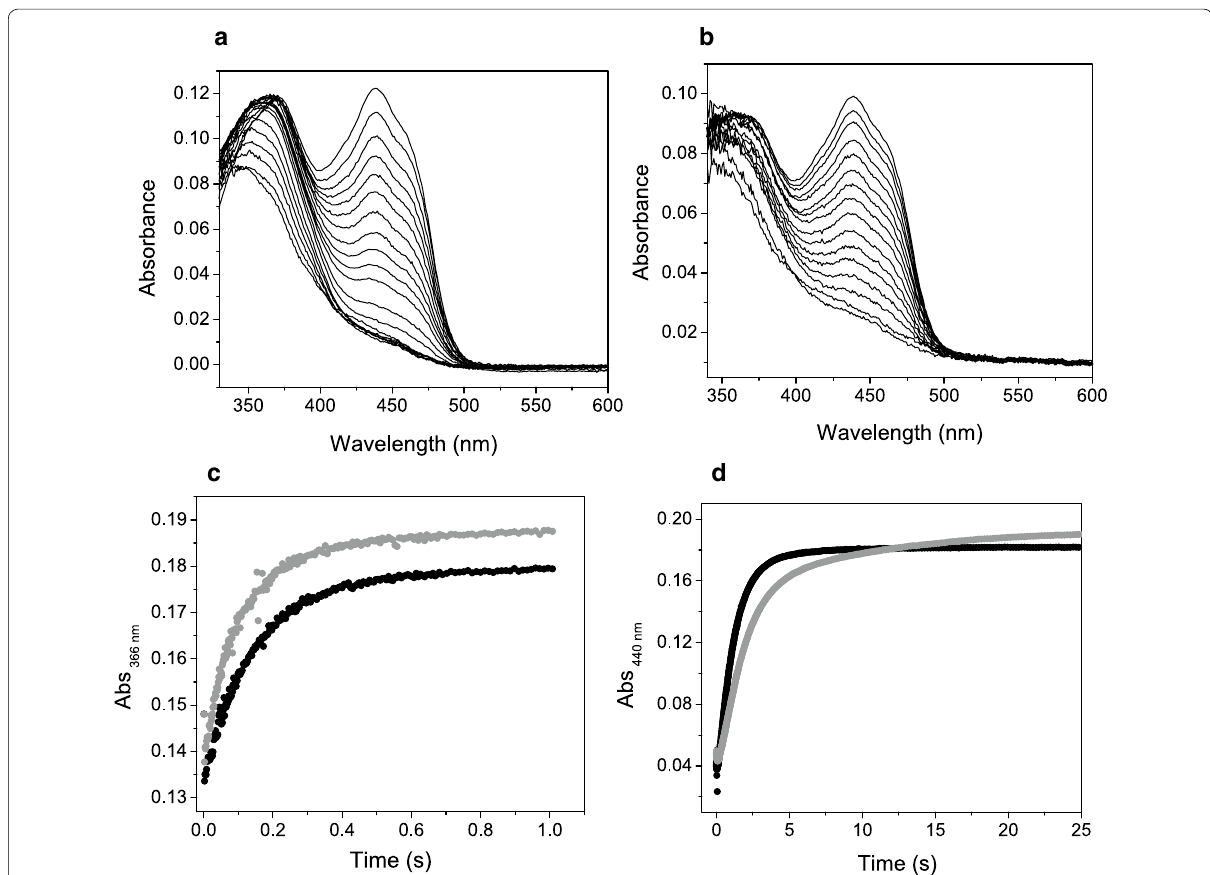
Fig. 7 a Time-resolved absorbance spectra collected over 75 s following the re-oxidation of reduced GSTACMO (20 μM) in the presence 500 μM NADP + with air-saturated buffer (50 mM HEPES pH 7.5, 20% glycerol). b The same experiment as performed as for panel A with the exception of 200 μM of butanone added to the air-saturated buffer. c Stopped-flow single wavelength traces at 366 nm following rapid mixing of reduced GSTACMO (20 μM) in the presence 500 μM NADP + against air-saturated buffer (50 mM HEPES pH 7.5, 20% glycerol) with 200 μM of butanone (black circles) and without butanone (grey circles). Fitting the data to a single exponential equation gave observed rate constants of 6.5 (with butanone) and 8.9 0.2 s − 1 (without butanone). d Stopped-flow single wavelength traces at 440 nm following rapid mixing of reduced ± GSTACMO (20 μM) in the presence 500 μM NADP + against air-saturated 50 mM HEPES pH 7.5, 20% glycerol with 200 μM of butanone (black circles) and without butanone (grey circles). The absorbance traces with butanone were fitted to a single exponential equation giving an observed rate constant of 0.80 0.01 s − 1 , and the absorbance traces without butanone were fitted to a double exponential giving rate constants of ± 0.47 0.01 s − 1 and 0.06 0.01 s − 1 ± ±